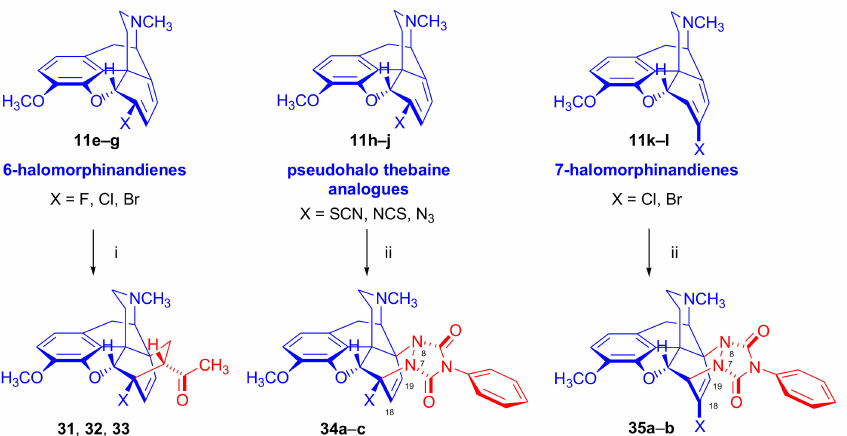
Figure 12. Cycloadducts of 6-halomorphinanedienes, 7-halomorphinandienes, and 6-pseudohalo thebaine analogues. Reagents and conditions : (i): methyl vinyl ketone, toluene, reflux, 24 h, 85–96%; (ii): PTAD, room temperature, 20